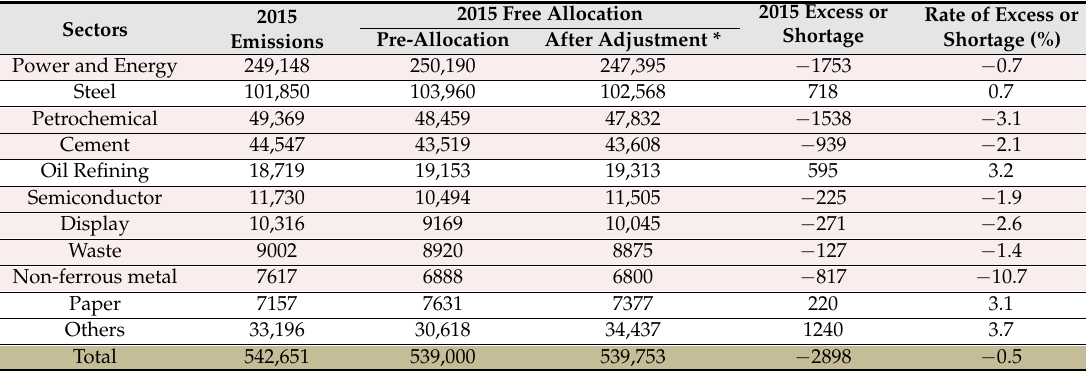
Table 1. Excess and shortage analysis of emission permits in main sectors in the first compliance year. Unit is 1000 Mt carbon dioxide (CO 2 ). Pink and white cells indicate shortage and excess of carbon permits respectively. In addition, dark grey cells (last row) indicate the total number of each